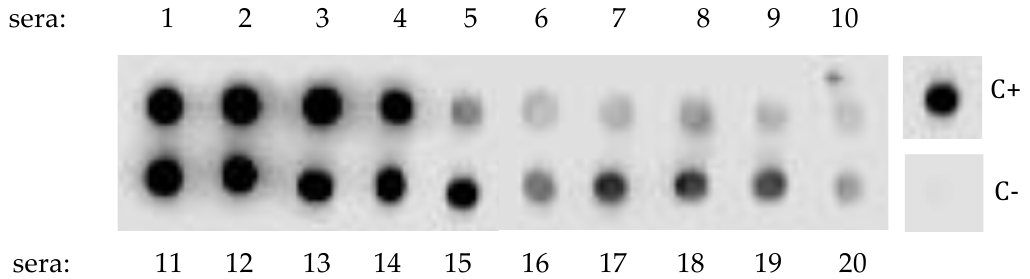
Figure 1. Dot-blot screening of the yellow mealworm protein extract (protein concentration of 15 mg mL − 1 ) by 20 sera from shrimp-allergic patients, revealed with an anti-IgE second antibody. Data not shown for the single nonreactive serum #21. Depending on the patient sera, the IgE cross-reacting antibodies interacted strongly (dark dot) or weakly (grey dot) with the immobilized protein extract. No data for sera from dust mite allergic patients were shown because most of them (11 / 13), gave negative results. C + and C − correspond to the positive and negative controls (first IgE antibody omitted) performed with a shrimp protein extract,